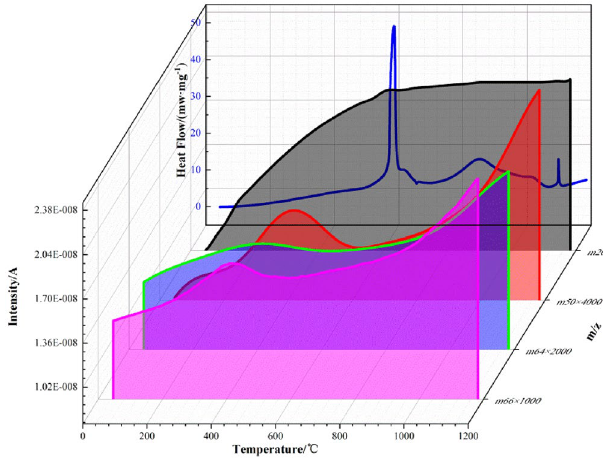
Figure10. MS spectrum with F containing